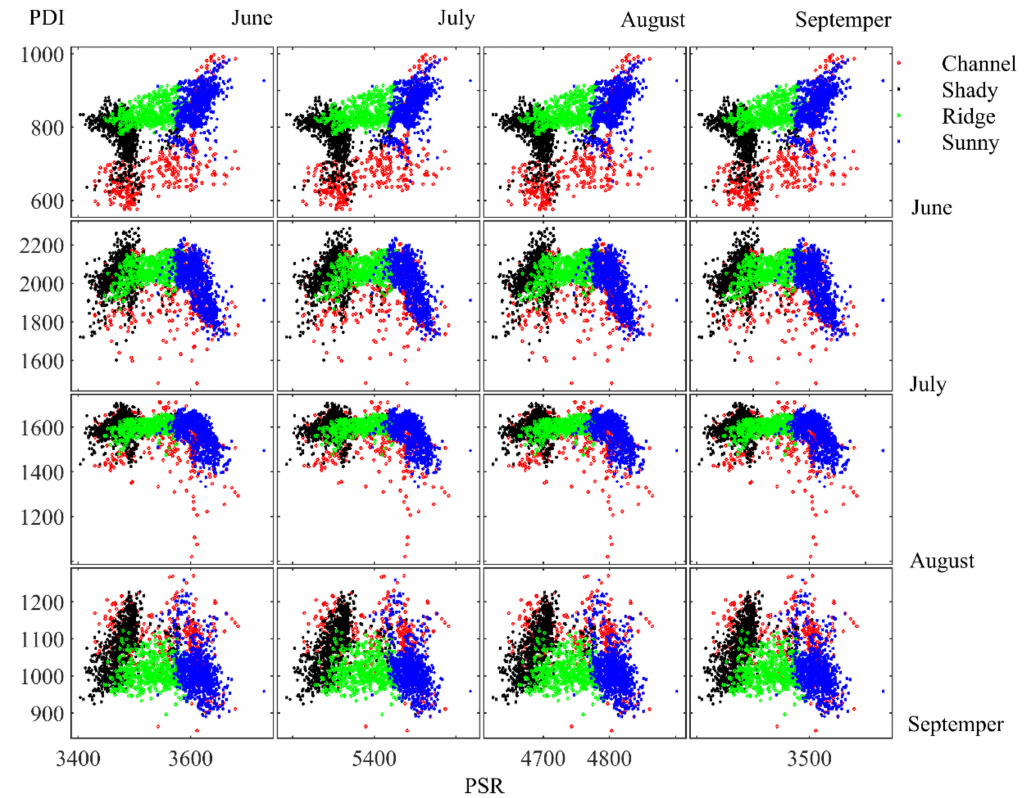
Figure 5. Scatter plot of PDI and PSR at di ff erent slope positions.